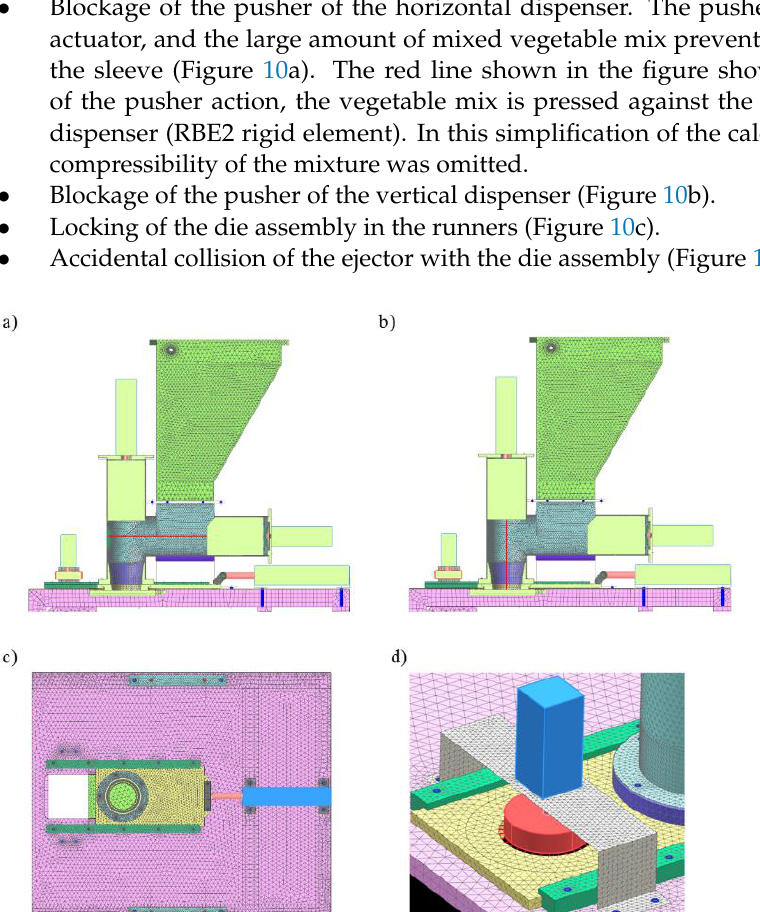
Figure 10. Load cases including forces from pneumatic actuators in undesirable situations: ( a ) blockage of the pusher of the horizontal dispenser; ( b ) blockage of the pusher of the vertical dispenser; ( c ) blockage of the die assembly in the runners; ( d ) accidental collision of the ejector with the die assembly.